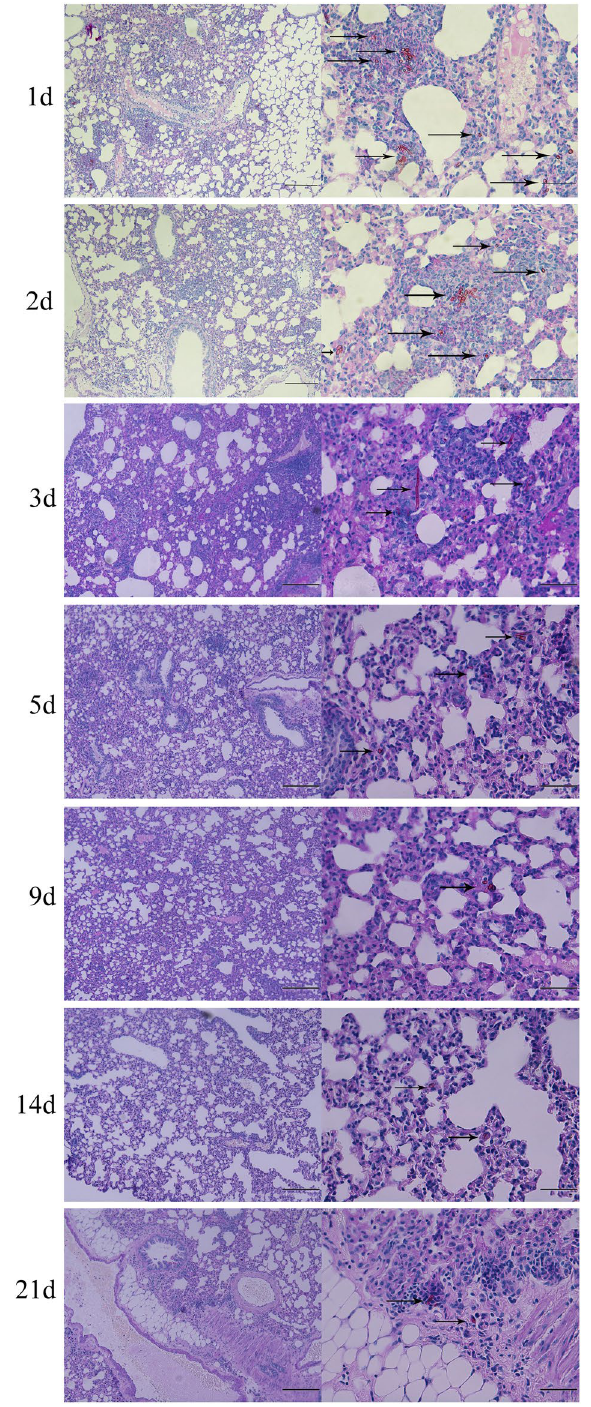
Figure 2. Assessment of the colonization of fungal spores and mycelia in pulmonary structures in mice intravenously infected with Cladosporium cladosporioides. A larger number of spores and mycelia colonized the lung tissue on days 1, 2, and 3 post-inoculation (PI) compared to days 5, 9, 14, and 21 PI. The spores and mycelia are indicated with arrows. Data are representative of three independent experiments (n = 3 mice per group). Scale bars, left-200 μm, right-50